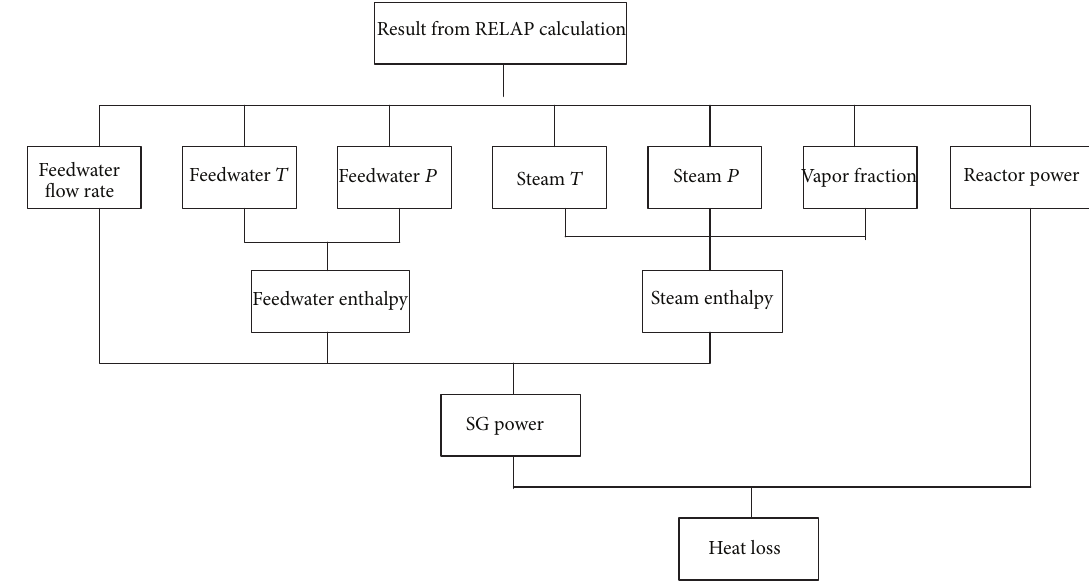
Figure 1: Structure of the heat loss package.